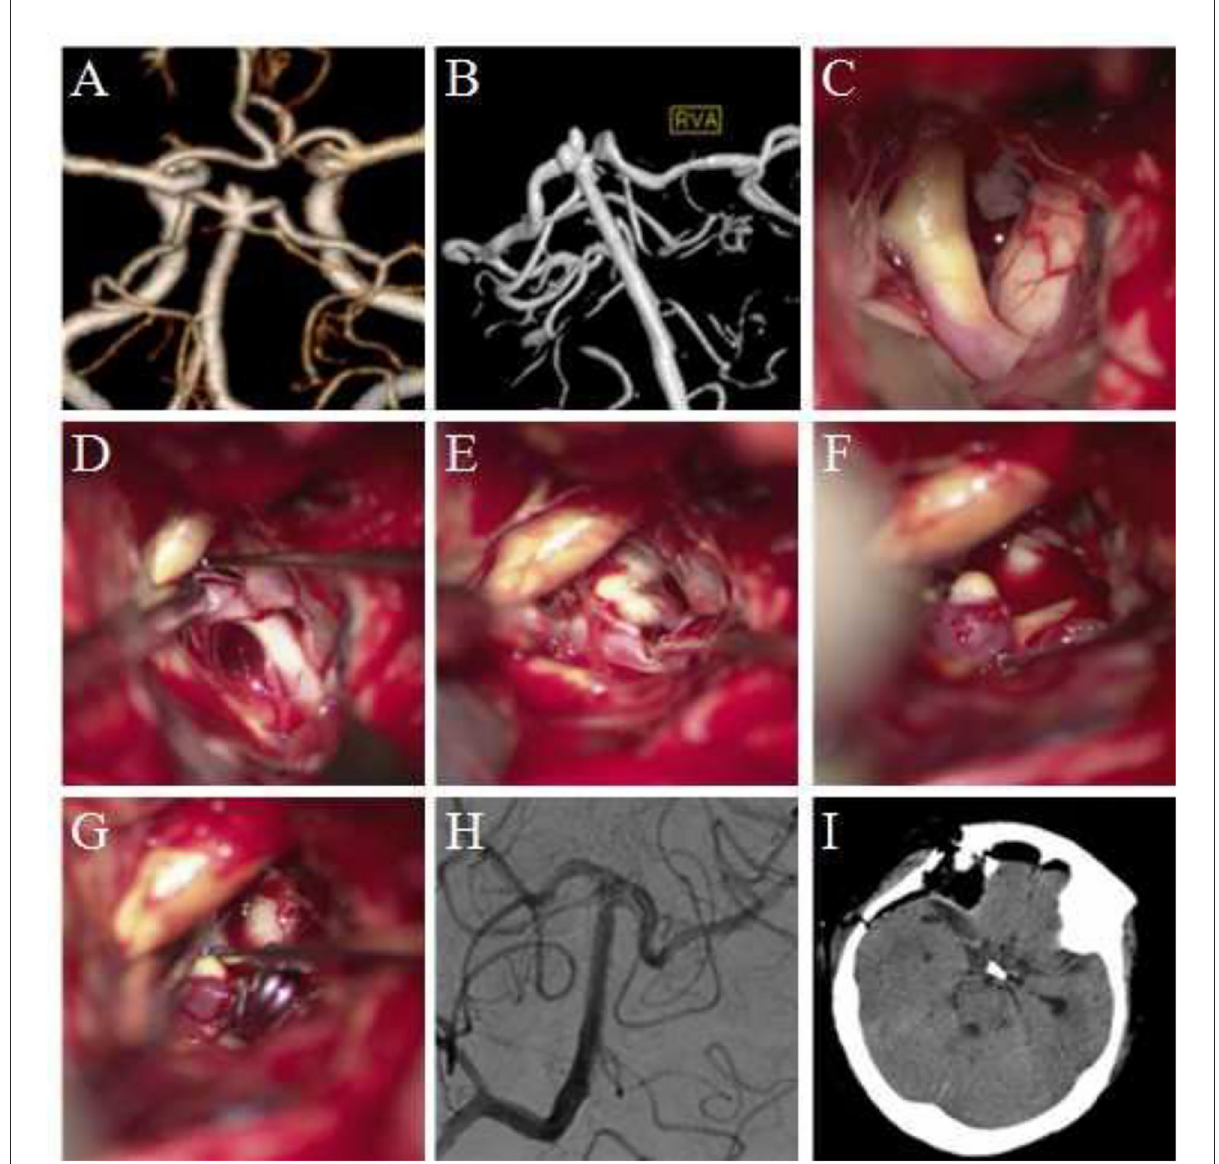
FIGURE1 Clipping of basilar artery apical aneurysm via the Dolenc approach. (A,B) Preoperative computed tomography angiography (CTA) and digital subtraction angiography (DSA) revealed a basilar artery apical aneurysm; the aneurysm was lobulated. (C) During surgery, the internal carotid artery and the posterior clinoid process of the surgery side were exposed. (D) The internal carotid artery was pulled medially, and the exposure range was increased. The P1 segment of the posterior cerebral artery and its perforating arteries were visible. (E) The basilar artery was exposed along the posterior cerebral artery to the top of the basilar artery. The aneurysm was exposed, and the sub-aneurysm was visible. (F) The aneurysm was completely exposed, and sub-aneurysms were visible. (G) The neck of the aneurysm was clipped. The basilar arteries, bilateral posterior cerebral arteries, and superior cerebellar arteries were explored, and no vascular damage was observed. (H) Intraoperative DSA revealed no development of aneurysm and no vascular damage. (I) Re-examination was performed using the head CT within 12h after surgery.